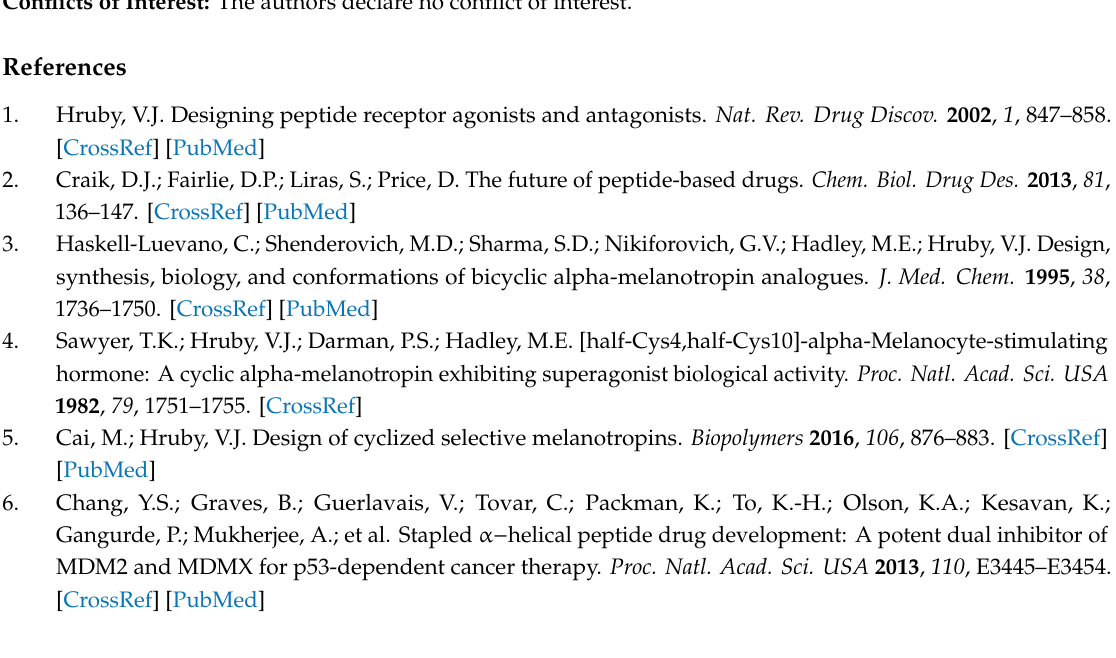
Supplementary Materials: The following are available online, Figure S1: Mass spectrometry and HPLC Spectrum of folded β